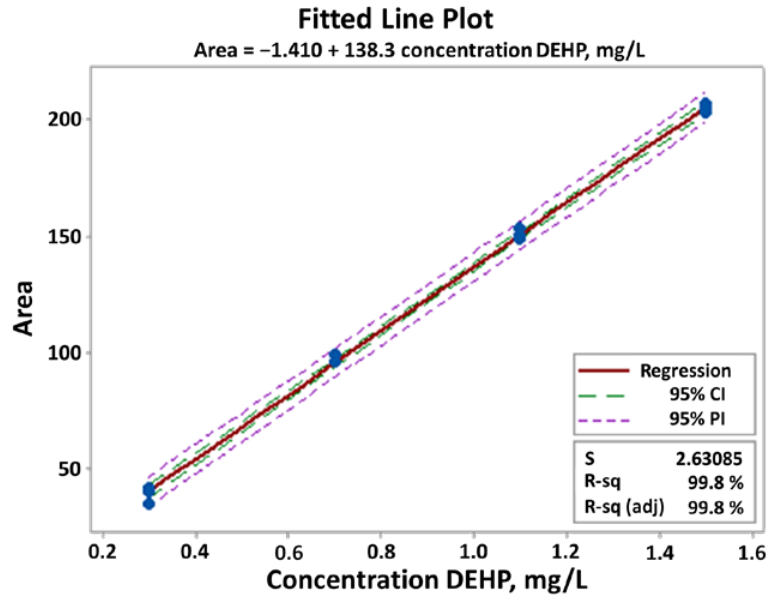
Figure 5. Calibration curve for DEHP determination method. The diagram shows: the 95% confidence and prediction intervals and the coefficient of determination, r 2 .